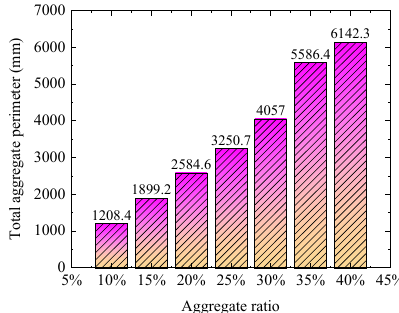
Figure 8. The total perimeter of the coarse aggregate for different aggregate ratios. Moreover, by comparing the chloride diffusion paths, coarse aggregate not only hinders the chloride diffusion, but also has an agglomeration effect on chloride distribution. Figure 9 shows an enlarged view of the local chloride ion diffusion path for 30% of the coarse aggregate. As well, the agglomeration of coarse aggregate increases the chloride ion concentration in the cement